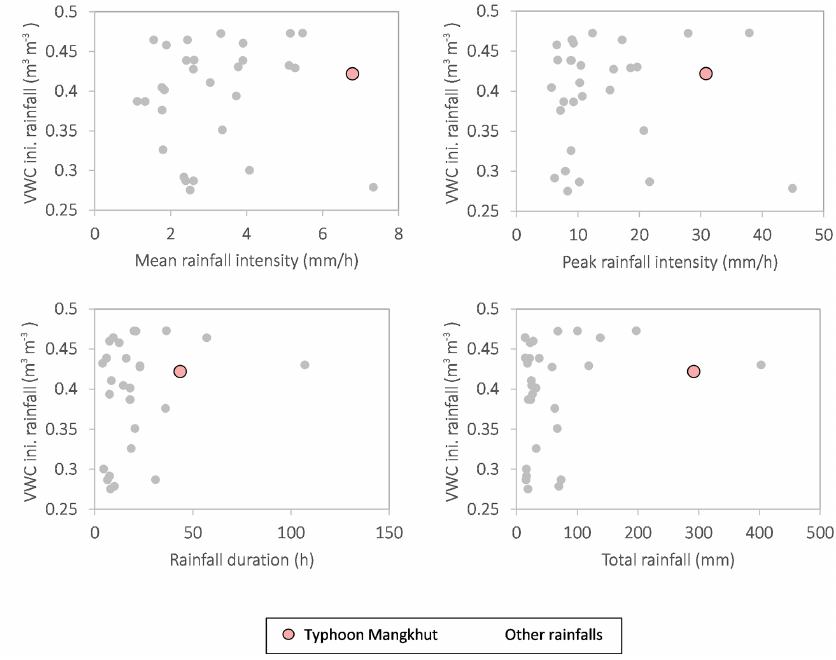
Figure 11. Correlation between soil moisture (a) mean rainfall intensity of the event (total rainfall/rainfall duration), (b) peak rainfall intensity during event, (c) duration of rainfall and (d) accumulated rainfall during the event for the 33 (and Typhoon Mangkhut) high-intensity rainfalls in the study area (see Fig. 7). Soil moisture data obtained from SMAP-L4 data at point C and rainfall data from GPM IMERG at point Y (see Fig.